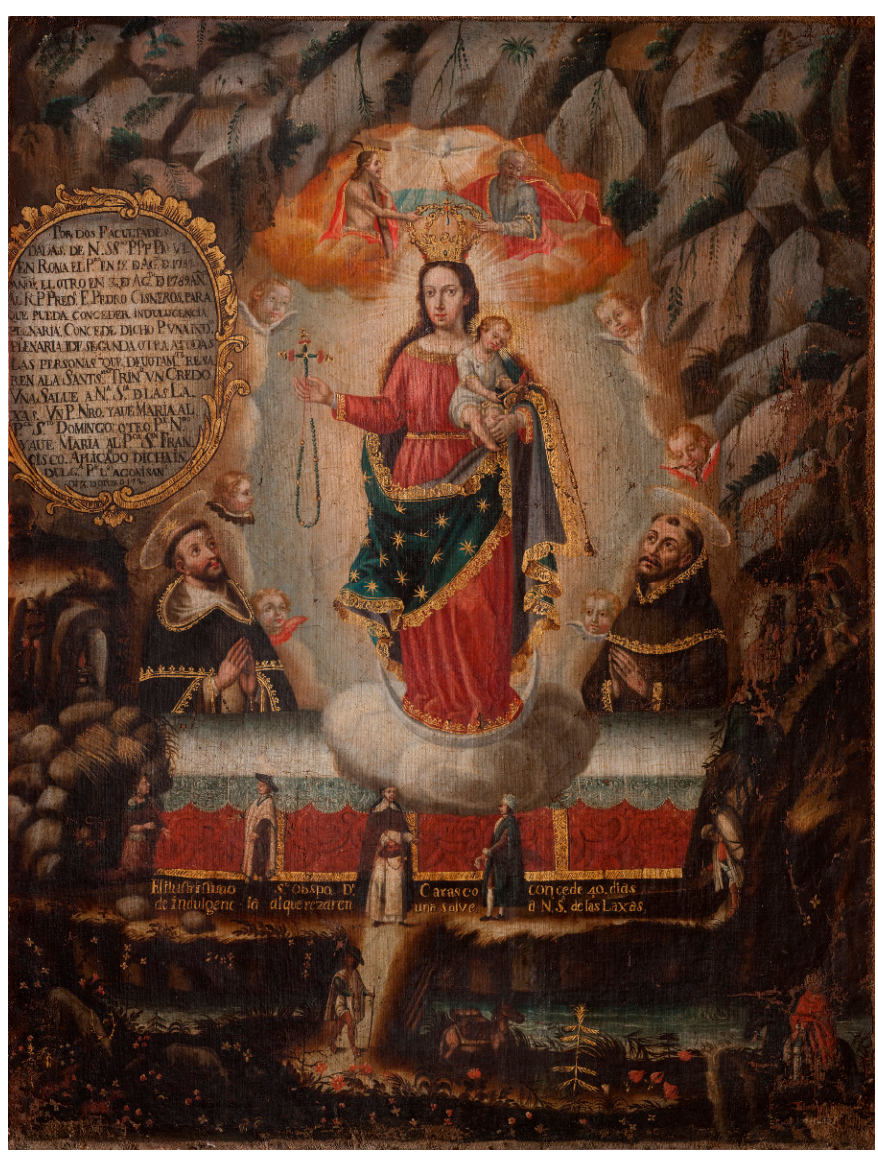
Figure 2. Our Lady of Las Lajas; oil on canvas; 1790; Convento de la Concepción, Quito (Photo: Christoph Hirtz, with permission).